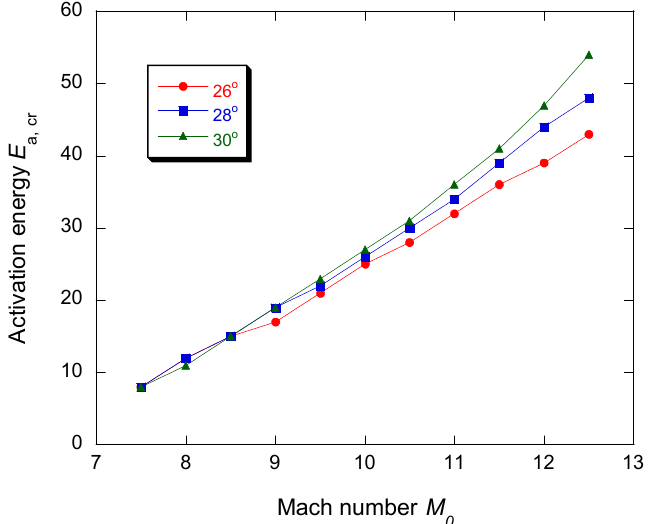
Figure 11. The conditions for smooth and abrupt transitions below and above the boundary respectively in the E a,cr – M 0 plane for three different wedge angles θ .